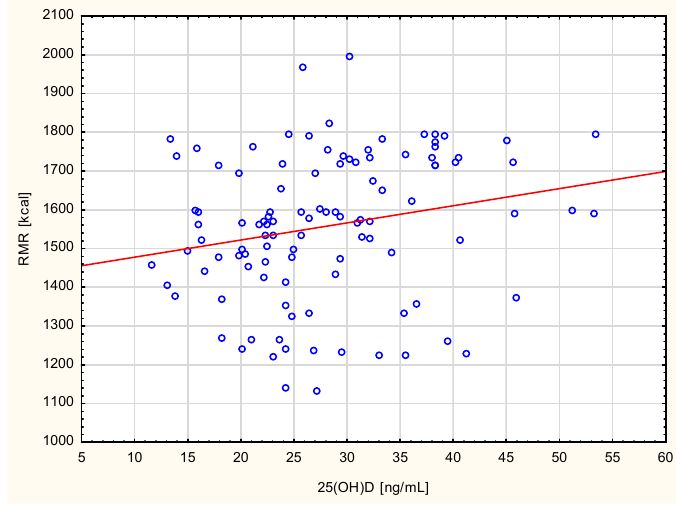
Figure 1. Correlation between 25(OH)D and RMR in healthy women. Table 2. Characteristics of the participating women according to 25(OH)D concentration.